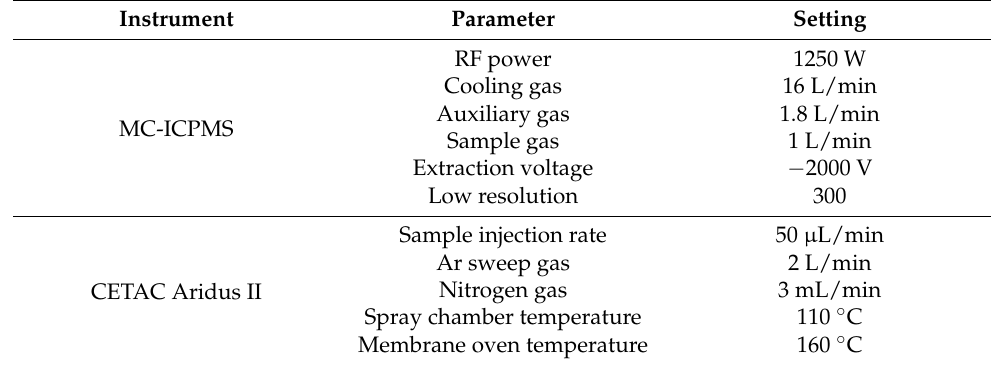
Table 2. Instrument parameters. Instrument